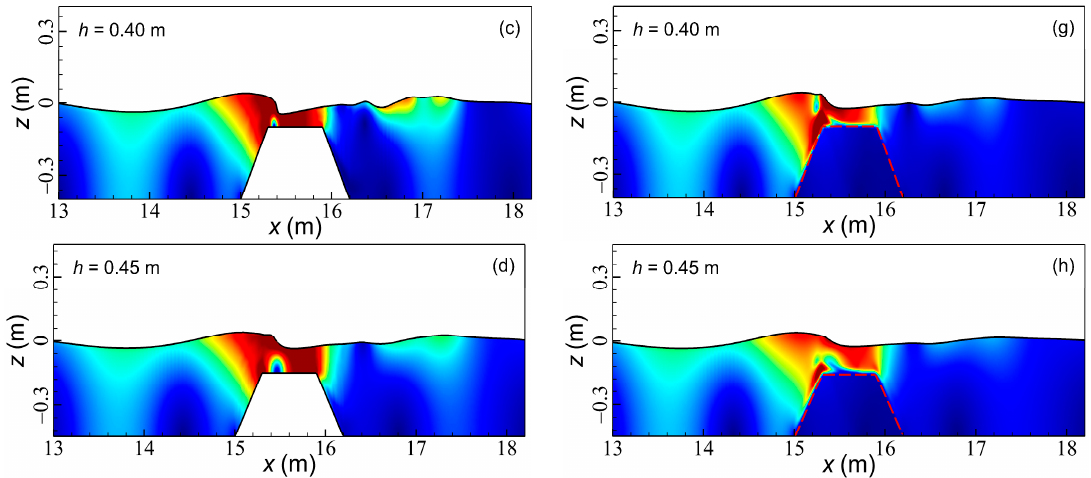
Figure 16. Snapshots of the water velocity contour with different water depths; left side ( a – d ): submerged impermeable breakwater; right side ( e – h ): submerged permeable breakwater.